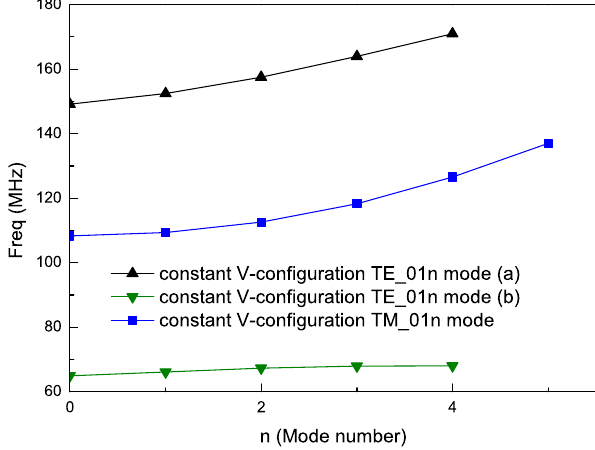
FIG. 11. Three dispersion curves from 3d simulation for the constant V-configuration, corresponding to three solutions of Eq. (13). (a) and (b) correspond to the two modes shown in Fig. 9.